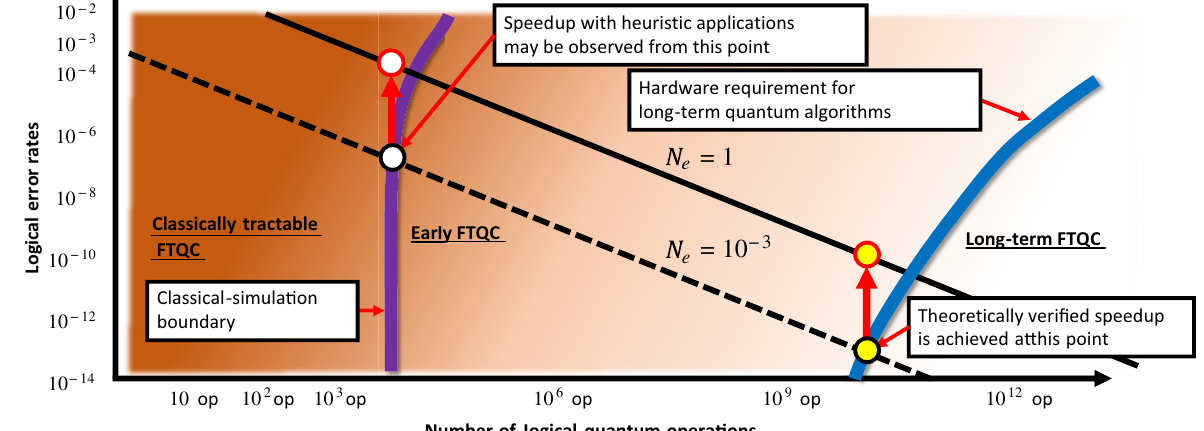
FIG. 1. Schematic picture representing the transitional period from the classically tractable FTQC regime towards the realization of the long-term FTQC. We are now in the classically tractable FTQC era due to the lack of physical qubits [11,12]. In the figure, the purple line indicates the hardware requirement for performing classically intractable tasks with a realistic time whereas the blue line corresponds to the requirement for demonstrating quantum advantages with conventional long-term quantum algorithms. To estimate these lines, we refer to the quantum supremacy experiments [13] and the existing state-of-the-art resource estimation [9,10,14]. The early FTQC regime is defined as a region between these lines. In the main text, we assume that the number of error events during FTQC N e is required to be smaller than 10 − 3 , which is shown as the dotted black line. Our technique allows for FTQCs with the number of error events in the order of unity N e ∼ 1, which is shown as a solid black line, to execute applications that originally require a much smaller error-event count. For example, at the beginning and the end of the early FTQC regime, our technique allows simulating applications (white and yellow circles with black rims) with the relaxed hardware requirement (white and yellow circles with red